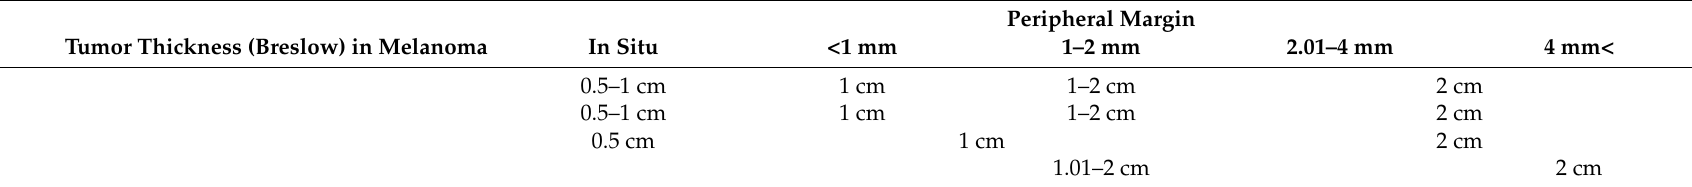
Table 2. Comparison of guideline-suggested peripheral margin in melanoma